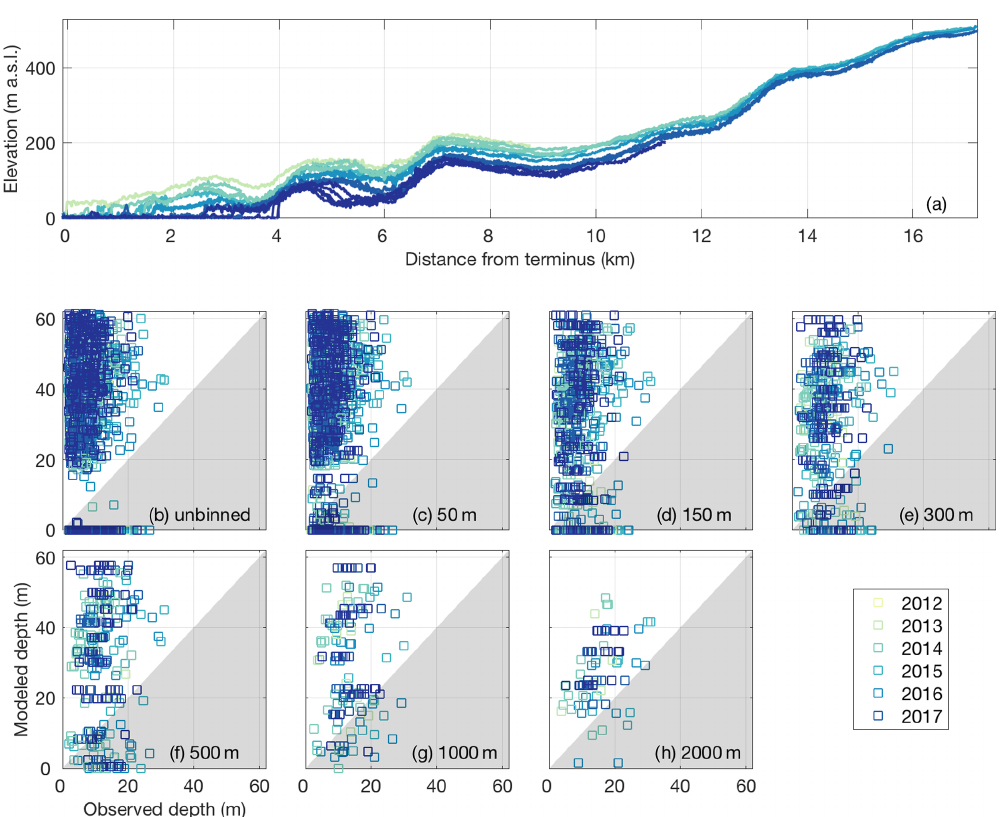
Figure 4. Inngia Isbræ (Greenlandic name: Salliarutsip Sermia) crevasse depth data. The legend indicates the observation year for all panels. (a) Elevation profile time series extracted along the OIB swath. (b) – (h) Scatterplots of observed crevasse depths plotted against crevasse depths modeled using the minimal Nye model. Points that fall in the white (gray) region represent model overestimates (underestimates) of observed depths. All observations are shown in (b) , whereas the maximum observed and median modeled depths within along-flow bins are shown in (c) – (h) . The bin sizes in (c) – (h) (50–2000m) reflect the range of spatial resolutions for numerical ice flow